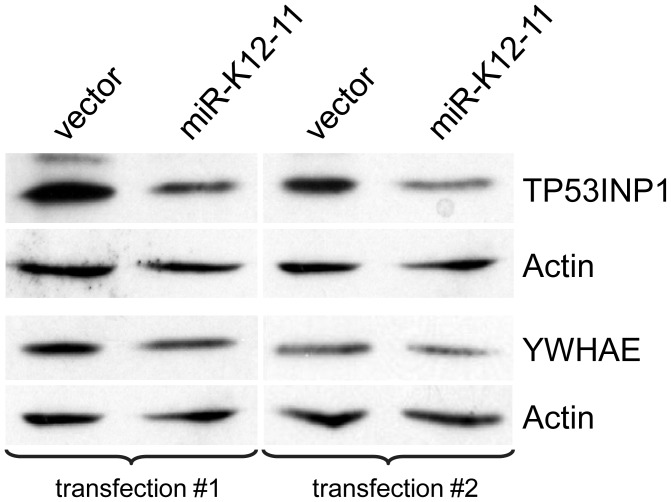
Western blot analysis of KSHV miRNA targets.Protein levels of two KSHV miRNA targets, TP53INP1 and YWHAE, were analyzed by Western blot in absence (0 ng) or presence (800 ng) of miR-K12-11 expression vector. Shown are two independent transfections of miR-K12-11. YWHAE showed moderate downregulation at the protein level, while TP53INP1 levels were reduced by more than 50% in the presence of miR-K12-11. Actin expression served as loading control.